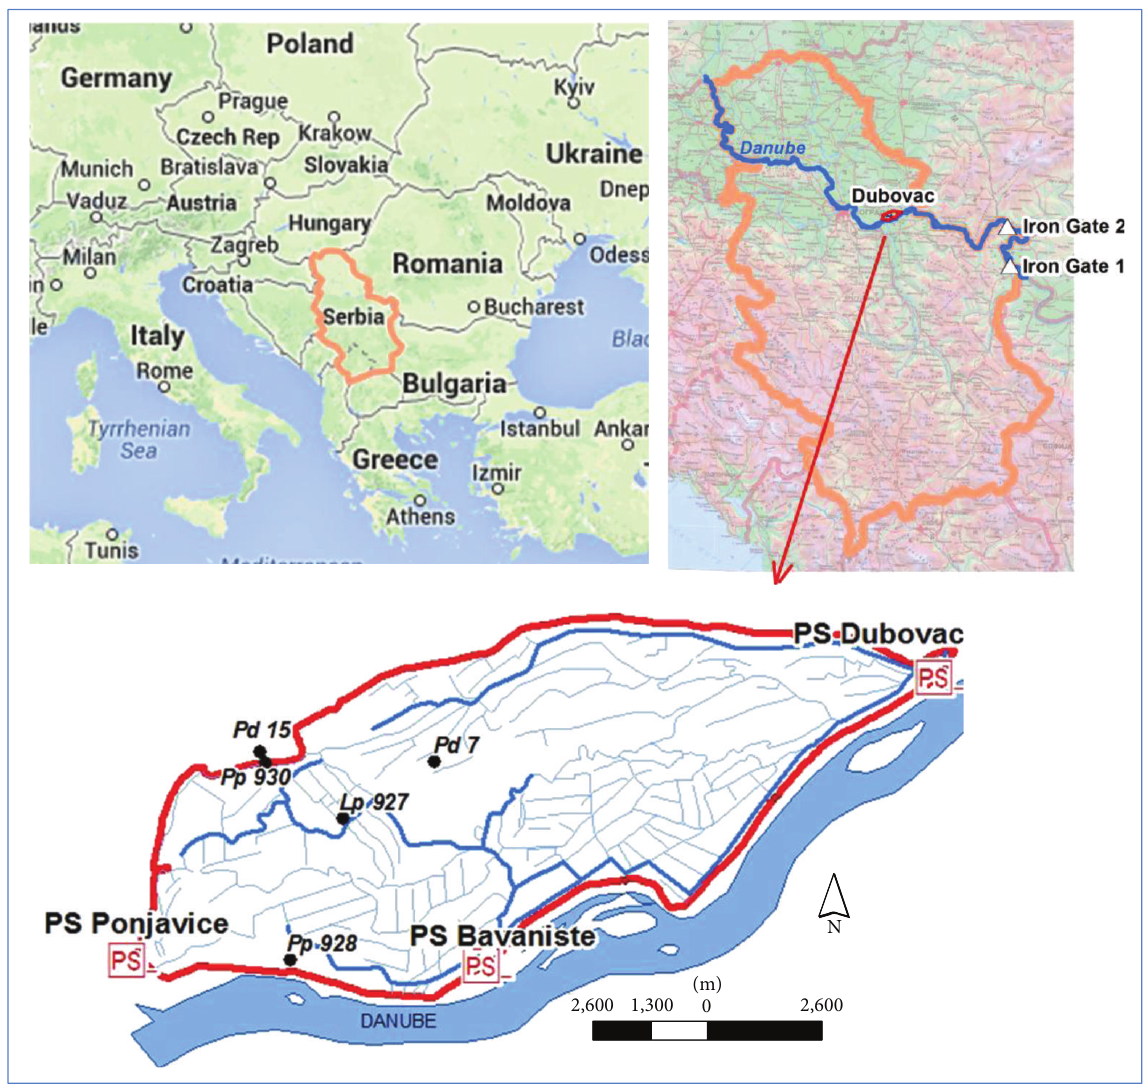
Figure 1: Location map of the study